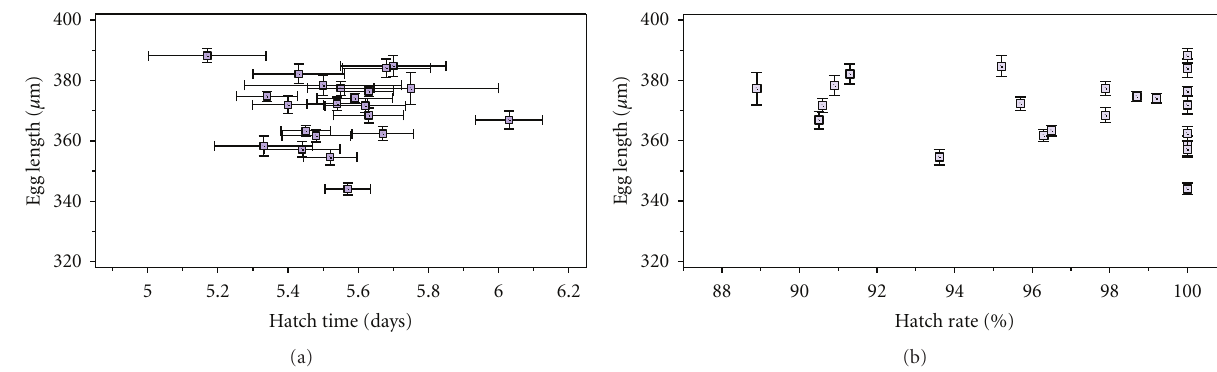
Figure 4: Mean ± SEM egg length versus mean ± SEM hatch time (a) or hatch rate (b) of eggs from 22 mothers, from trial 2 of the maternal size-egg size experiment. Mothers fed high quality prey only.